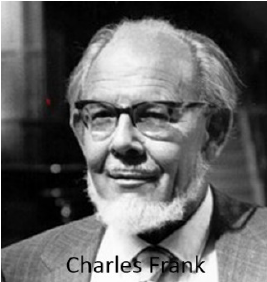
Figure 4. Sir Charles Frank had a lasting impact on British liquid crystal research, despite having not published many papers on the topic himself.